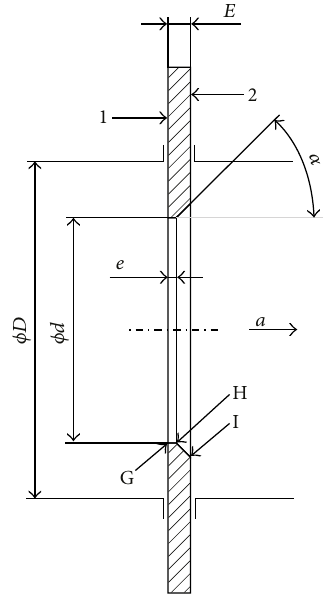
Figure 61: Geometry of the diaphragm.